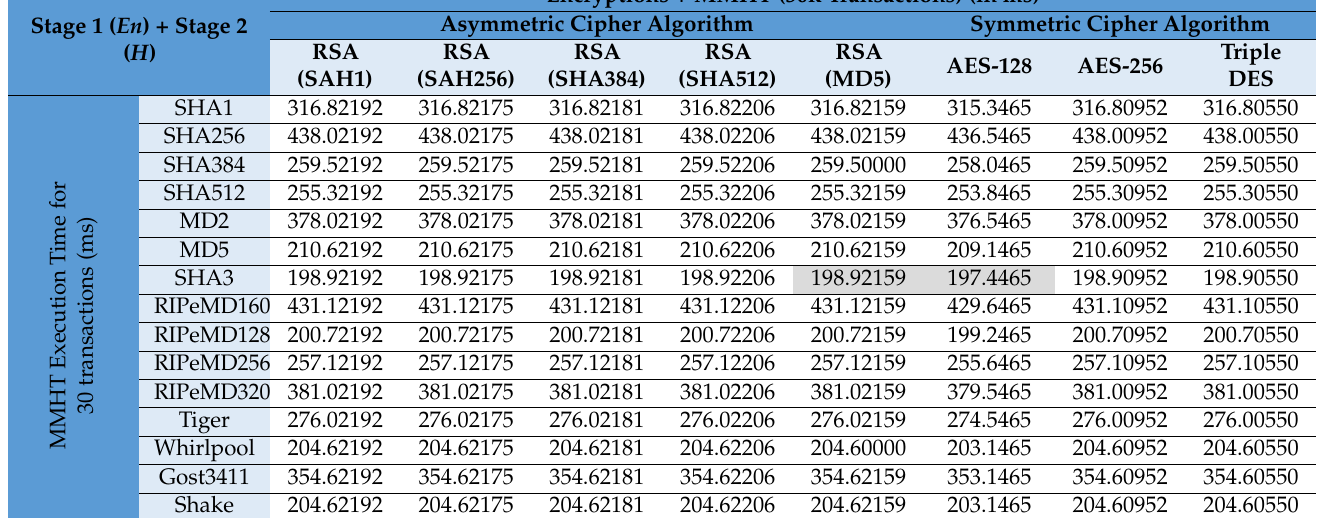
Table 4. Comparison of integrated signature and MMHT algorithm execution time using 30k transac- tions